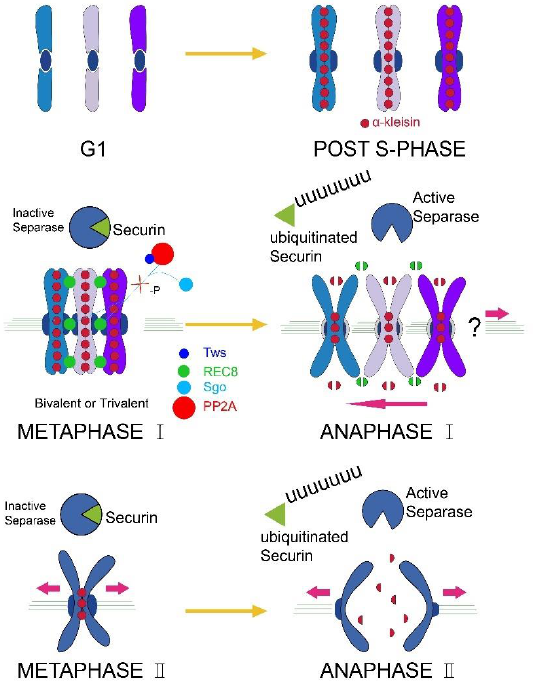
Figure 2. Triploid parthenogenetic RWW meiotic pattern diagram. Parthenogenetic RWW has three chromosome sets (G1). In S phase, chromosome duplication (POST S-PHASE). The low expression of Tws prevents the PP2A protein from maintaining the low phosphorylation state of the chromosome (METAPHASE I), which causes the REC8 protein to be cleaved by Separase earlier. All chromosomes segregate at one pole of the meiotic spindle during the anaphase of meiosis I (ANAPHASE I). Subsequently, the oocyte undergoes a standard meiosis II to produce triploid eggs (METAPHASE II and ANAPHASE